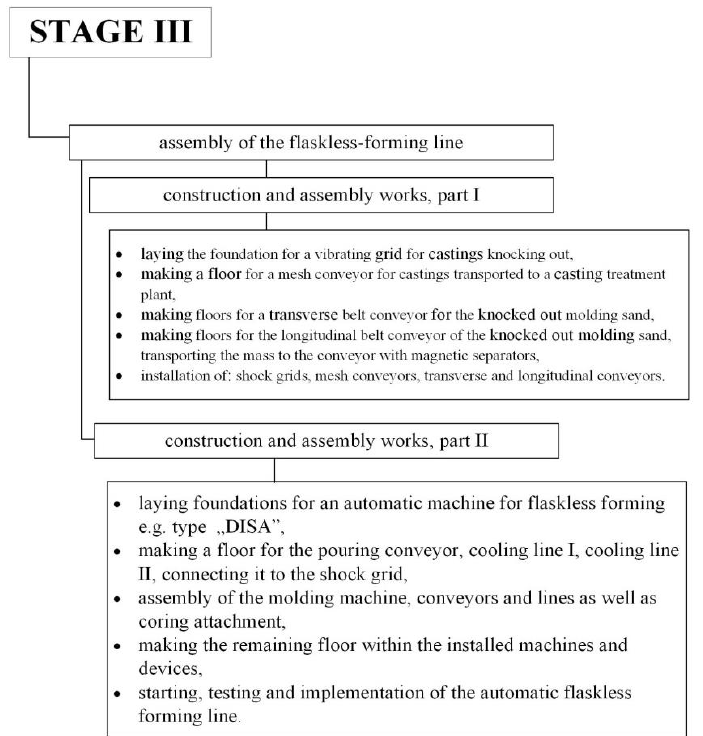
Figure 8. The second stage of modernization of the casting process.